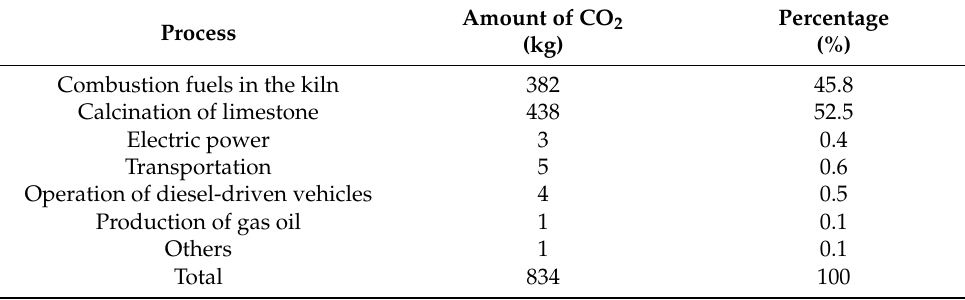
Table 7. Amounts and sources of alternative fuel CO 2 emissions per ton of OPC [22]. Amount of CO 2 Percentage Type of Fuel